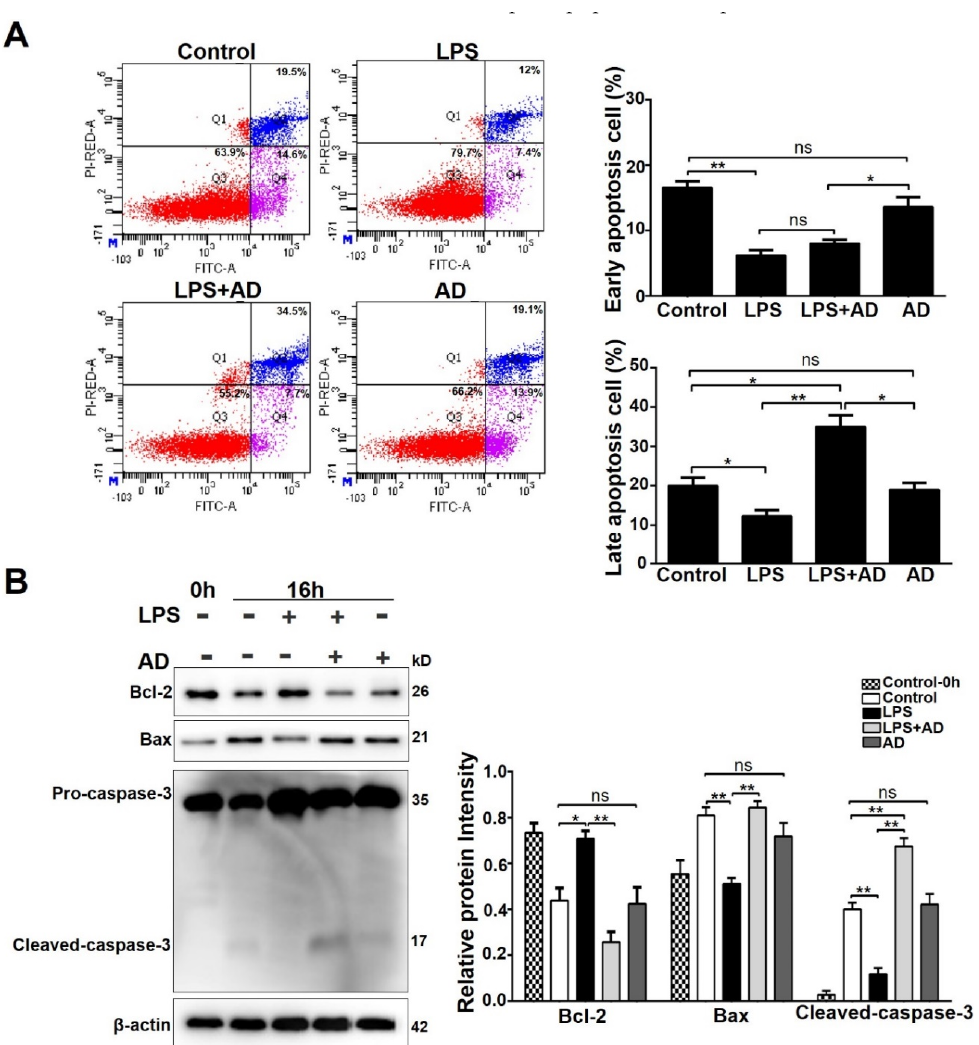
Figure 3. AD accelerates neutrophil apoptosis in the presence of LPS. Neutrophils were